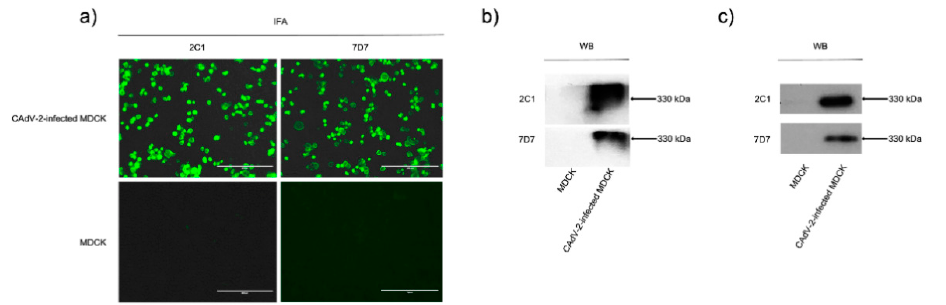
Figure 1. Identification of mAbs reacting with CAdV ‐ 2 by indirect immunofluorescence and Western blot . MDCK cells were infected with CAdV ‐ 2 at a multiplicity of infection (MOI) = 10 for 24 h, and mAbs 2C1 and 7D7 were used to detect the virus ( a ) by indirect immunofluorescence assay (magnification = 200×); ( b ) Western blot (WB) after native PAGE; and ( c ) WB after SDS ‐ PAGE.